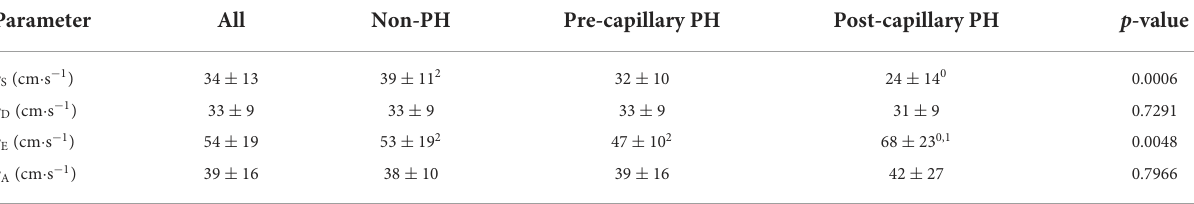
TABLE 2 LA peak in- and outflow